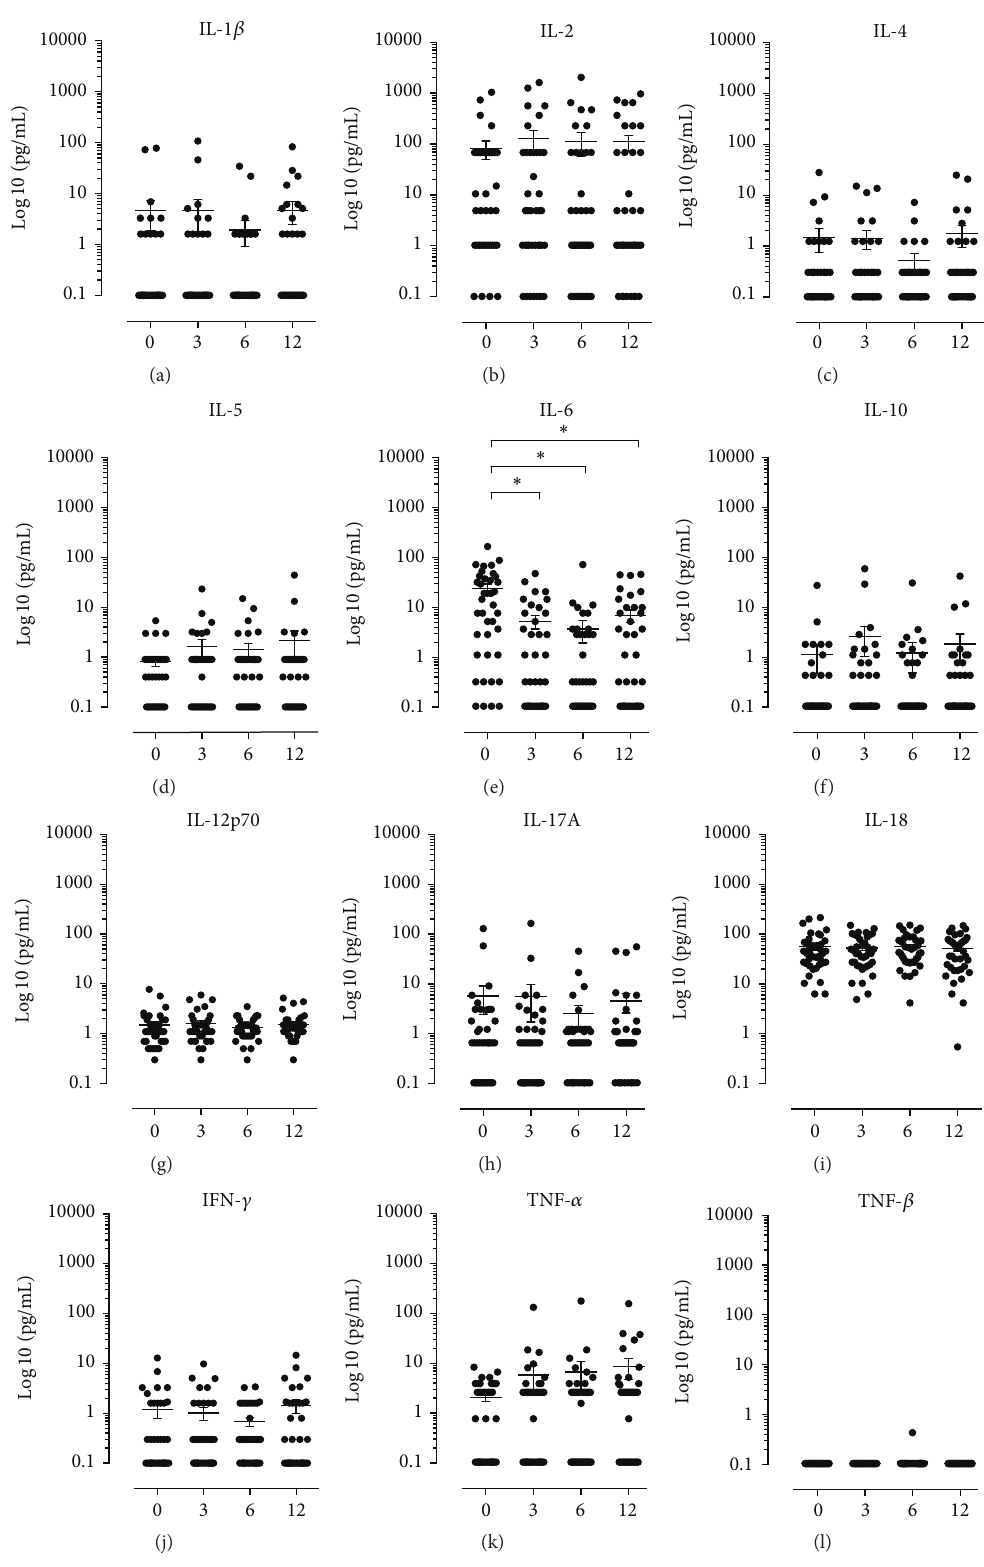
Figure 3: The serum cytokine levels in the rheumatoid arthritis patients. (a) to (l) are scatter dot plots of serum cytokine levels, where each dot represents one individual patient. The 𝑥 -axes illustrate the four assessment months after infliximab treatment is initiated. The concentrations in serum of their respective cytokine in picograms per millilitre (pg/mL) on a log 10 scale. The horizontal lines in the dot plot illustrate the mean, and the vertical error lines represent ± standard error mean (SEM) in a paired 𝑡